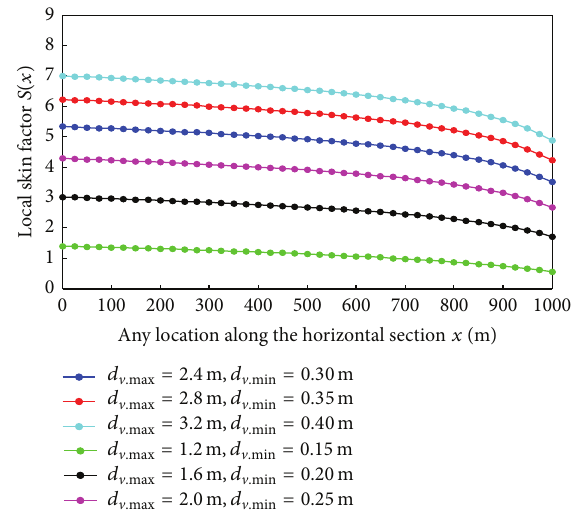
Figure 7: Effect of distance of mud immersion ( 𝑑 V . max , 𝑑 V . min ) on skin factor ( 𝐿 = 1000 m, 𝑟 𝑤 = 0.1 m, 𝜀 = 0.00016 m, 𝛾 𝑔 = 0.56 , = 0.023 mPa ⋅ s, 𝑍 = 0.9 , 𝑇 = 366 K, ℎ = 10 m, 𝑝 𝜇 𝑔 = 0.6 mD, 𝐾 = 0.1 mD, 𝐾 𝐾 ℎ V = 0.15 1.2 m, and 𝑎 V . min